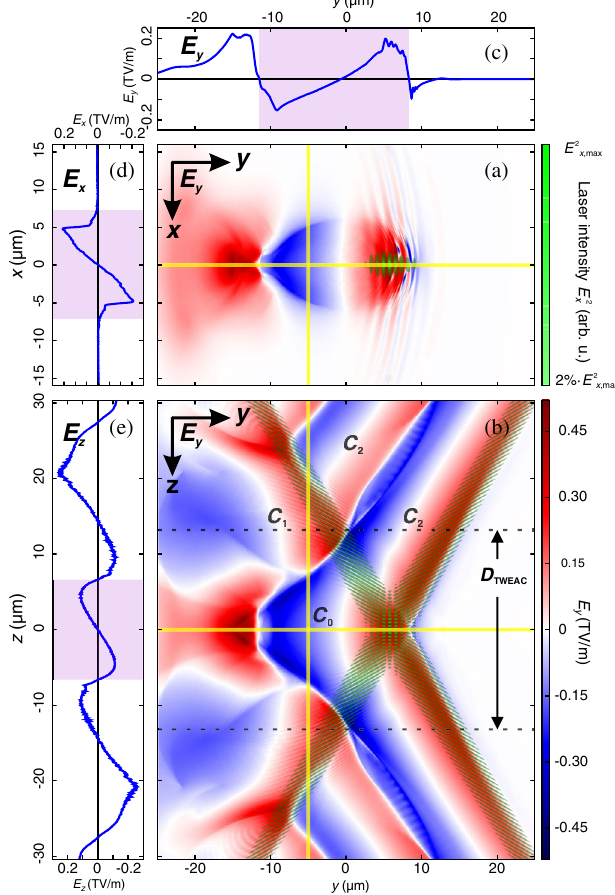
FIG. 2. Traveling-Wave Electron Acceleration fields E are on y the order of several 100 GV = m. (a,b) The longitudinal accel- eration E in (a) the xy plane and (b) the corresponding y orthogonal laser plane of propagation ( yz ). The projections (c) – (e) show the acceleration and transverse focusing fields at selected axes (yellow), respectively. For illustrating the laser pulse position within the cavity, the intensity (green) is shown in the range ½ 0 . 02 ; 1 . 0 (cid:2) · E 2 . Here, D marks the maximum x; max TWEAC extent of the central cavity C 0 in the yz plane, and side cavity structures are labeled as C 1 (behind both lasers) and C 2 (between the laser arms). Because of the difference in transverse cavity extent defined by the laser pulse geometry, the focusing fields of the xy plane are stronger compared to the yz